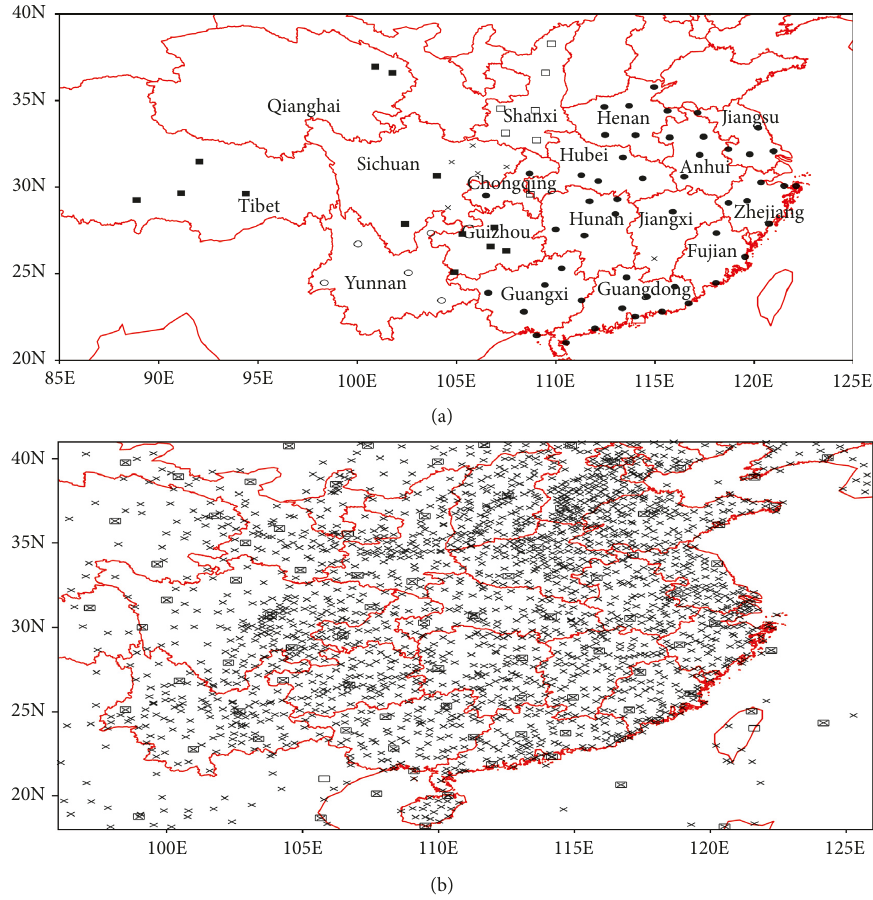
Figure 1: (a) Locations of Doppler radar sites in China (black solid circle, hollow circle, solid square, hollow square, and CB, CD, CB, and SC, respectively), and (b) radiosonde (black hollow square) and surface meteorological sites (